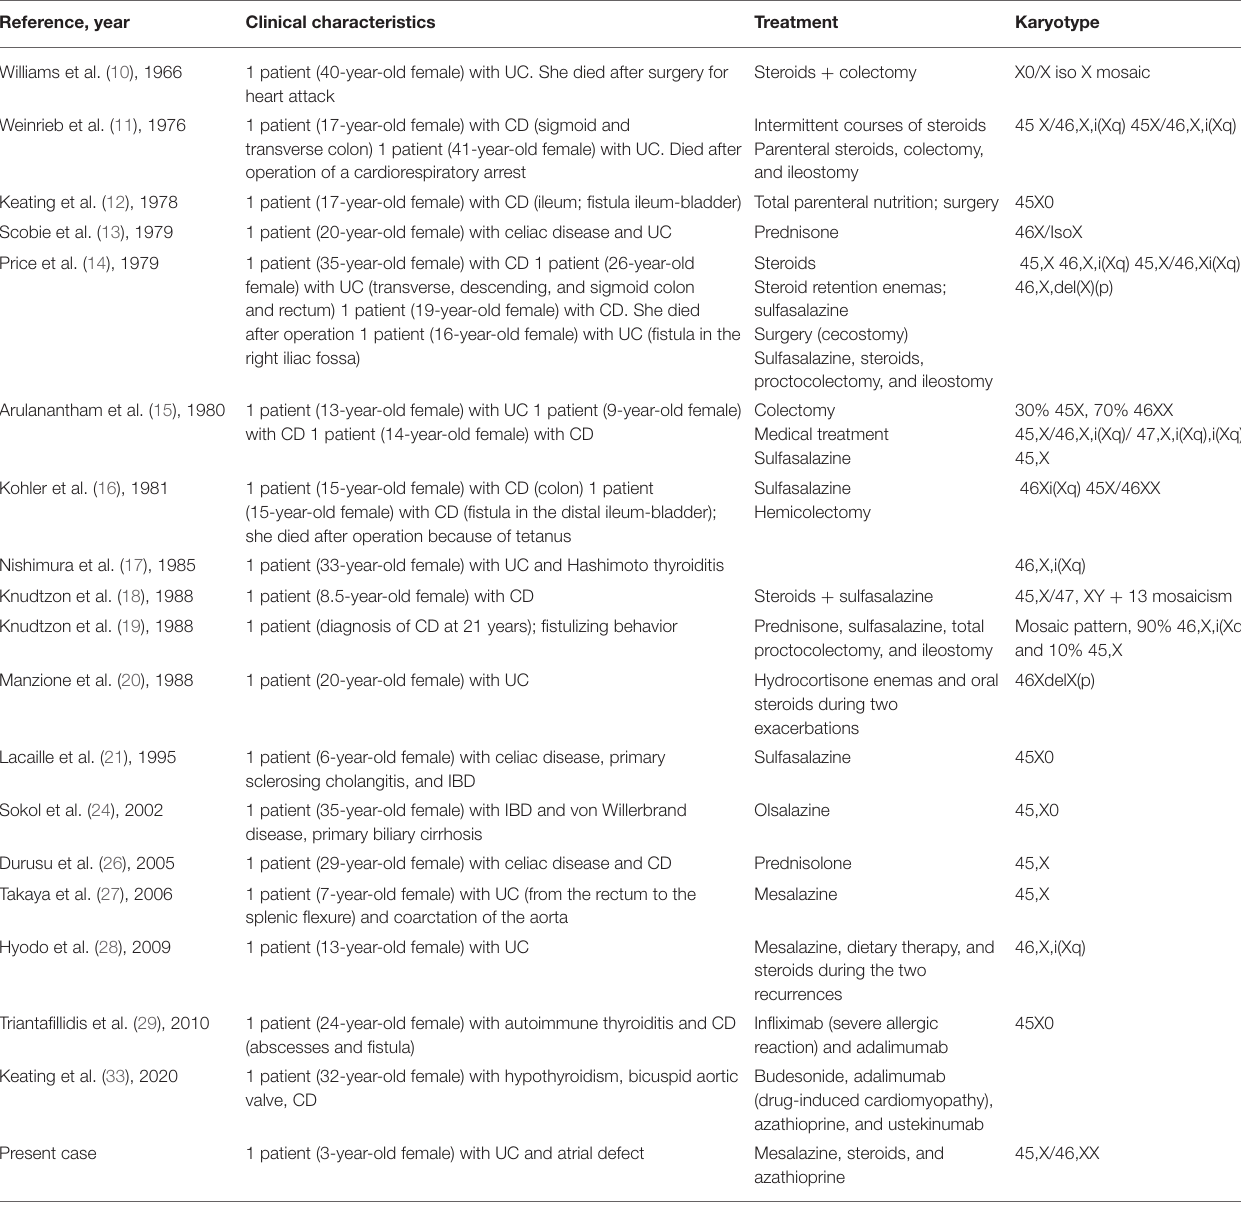
TABLE 2 | Clinical characteristics of the cases of IBD and TS detailed in